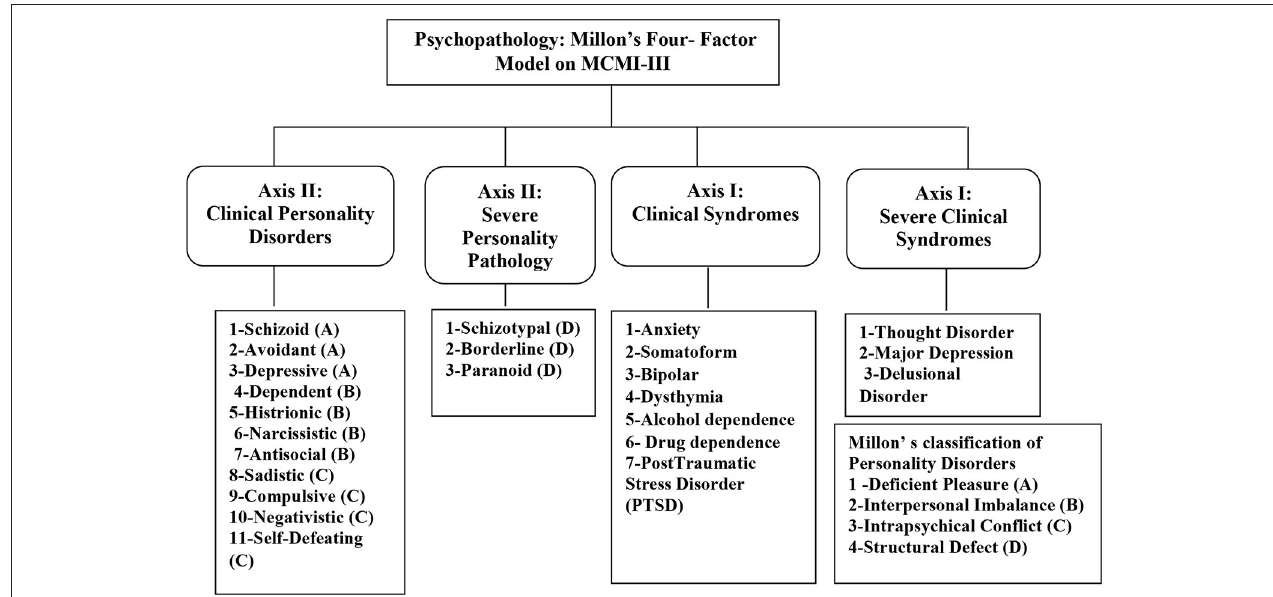
FIGURE 1 | The four-factor model of psychopathology of Millon classified on